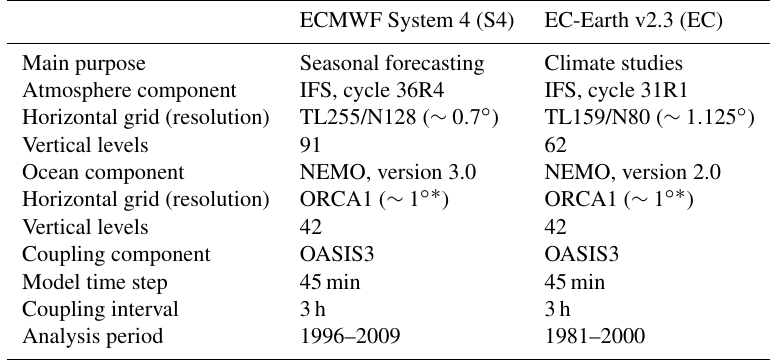
Table 1. Summary of the main features of the two coupled models used in this study. The features of the uncoupled model S4A are the same as S4, but with the SST prescribed and hence no ocean